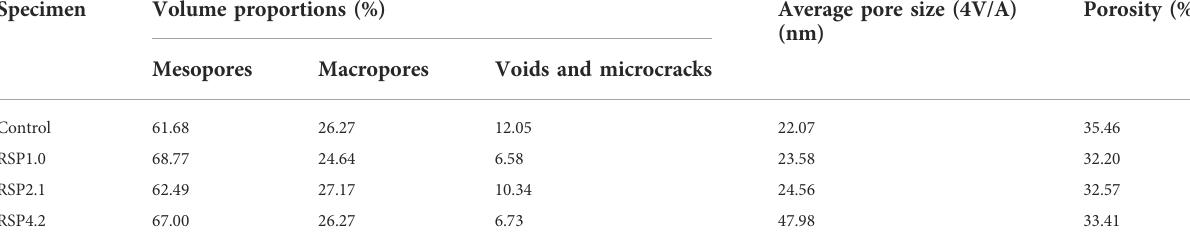
TABLE 6 Volume proportion, average pore sizes, and porosity of hardened mixtures at 28 days. Specimen